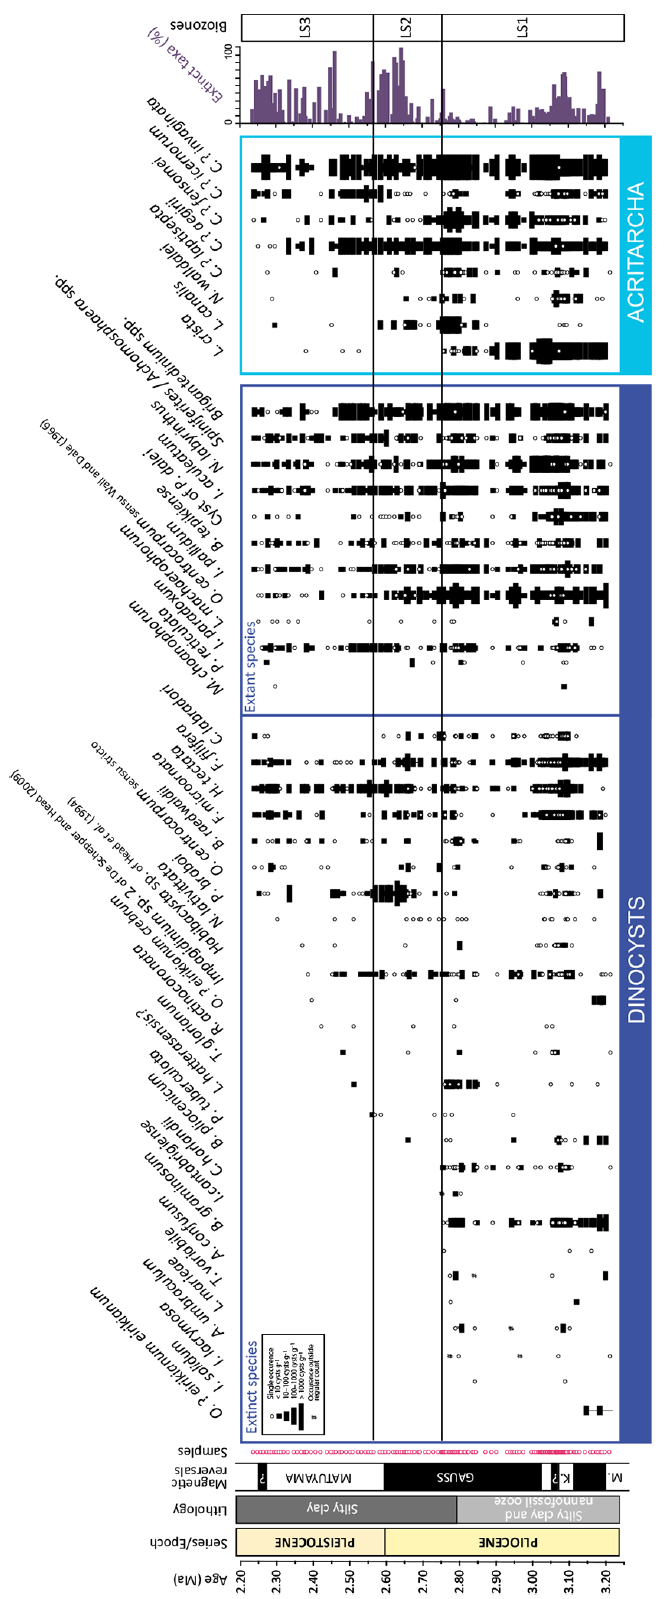
Figure 3. IODP Site U1307 stratigraphic occurrence of selected dinocyst and acritarch taxa and biozones defined in this study, calibrated against the Blake-Mizen et al. (2019) age model. All raw data are available in Data